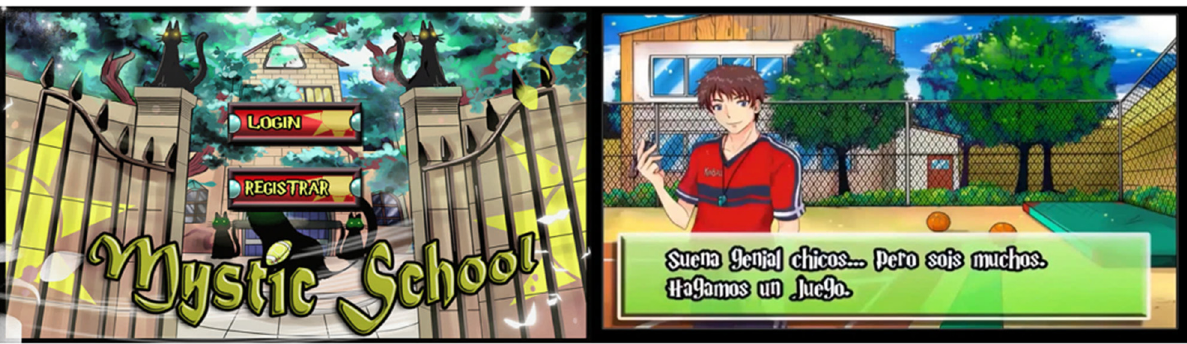
Figure 1. Registration in the video game and first explanation screen (Spanish version).